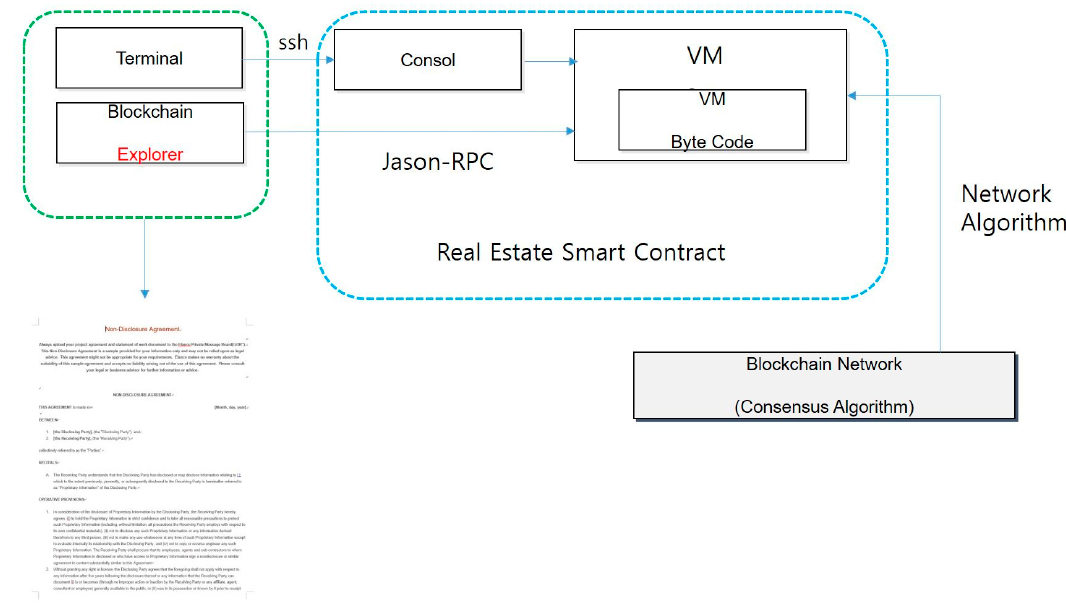
Figure 3. Smart contract for real estate.